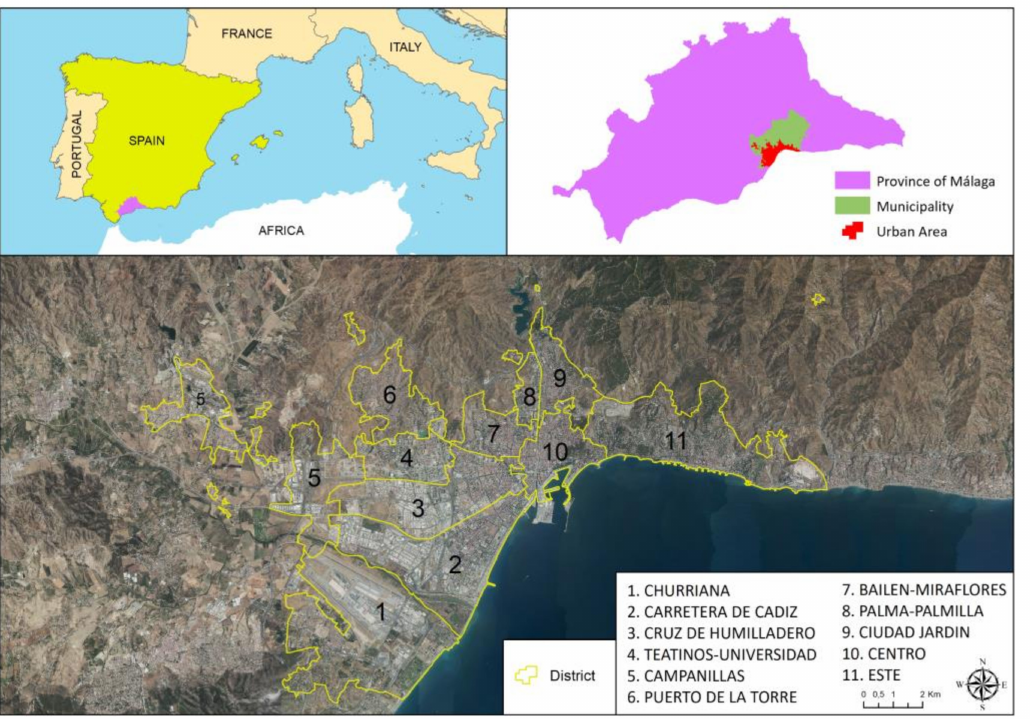
Figure 2. Location map of the study area and definition of urban areas. The numbered, yellow- outlined areas indicate districts, which are characterized by homogeneous social behaviors. Source: